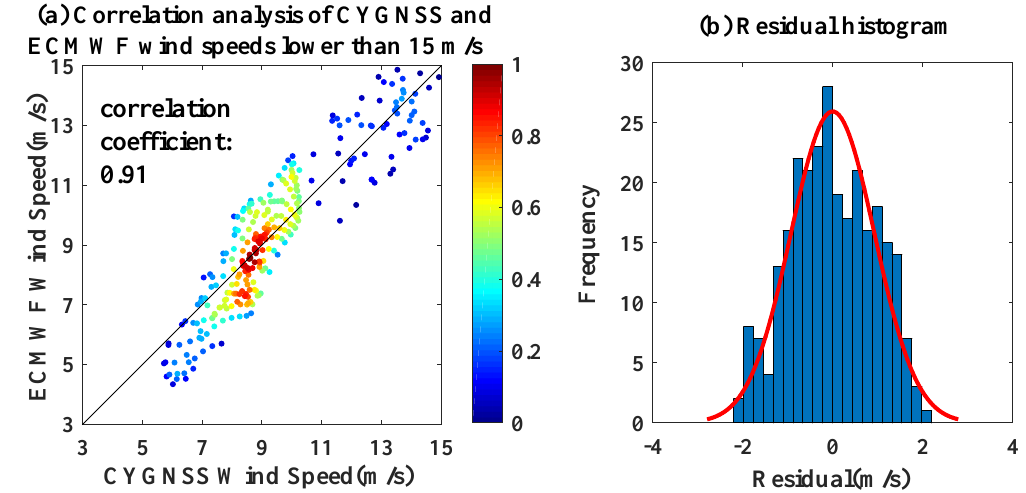
Figure 6. Scatter density plot and residual distribution of CYGNSS and ECMWF wind speeds lower than 15 m / s. ( a ) Scatter plot of CYGNSS and ECMWF winds lower than 15 m / s; ( b ) CYGNSS and ECMWF wind speed residual distribution histogram. The colors bar (from cool to warm) represents the change of scatter density from small to large values in a given